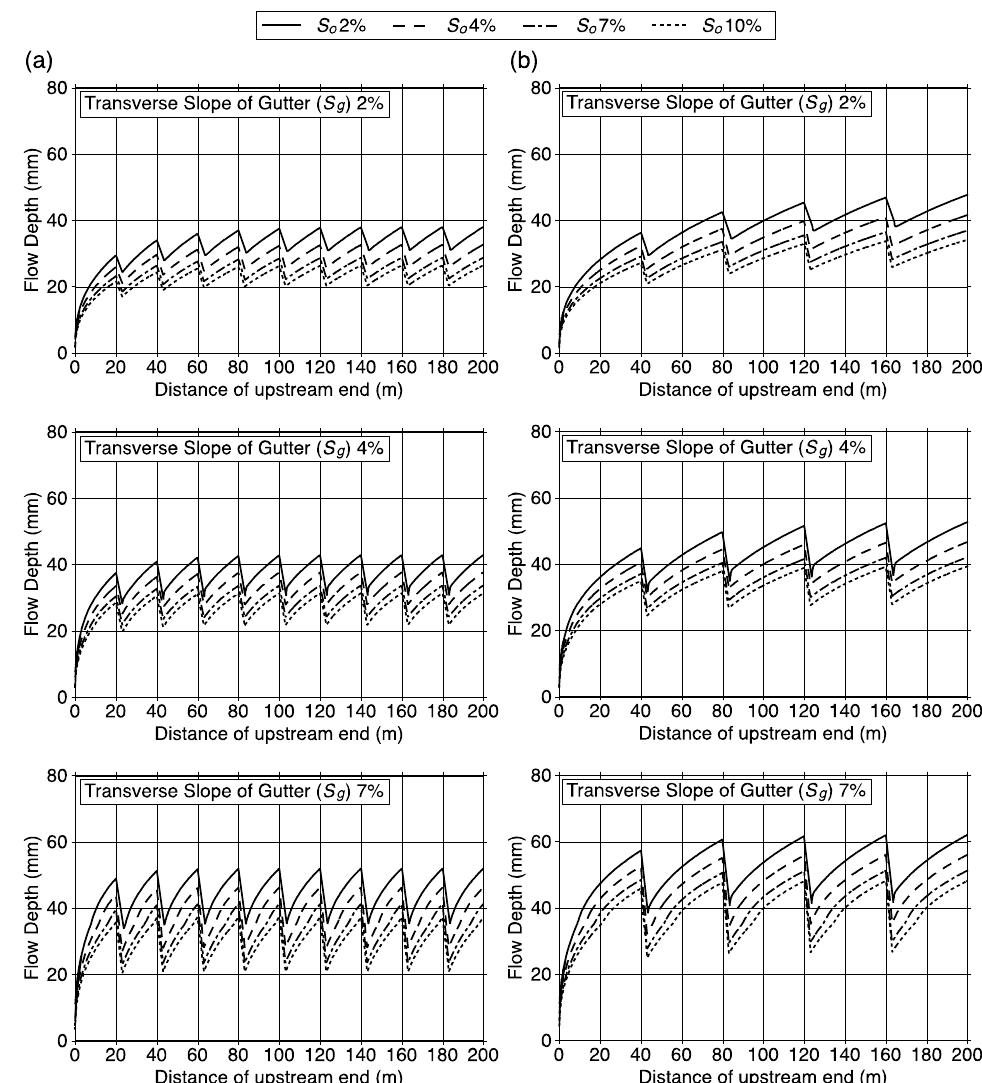
Figure 7. Changes in road surface flow depths considering the grate inlet installation interval and intercepted discharge: ( a ) Inlet installation interval of 20 m and ( b ) inlet installation interval of 40 m.